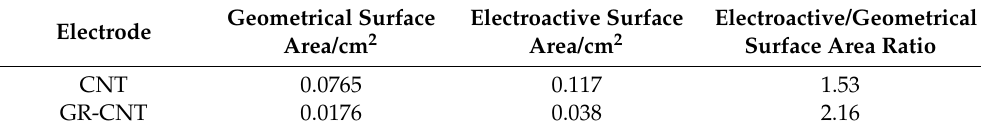
Table 2. Electroactive surface areas in comparison with geometrical ones. Geometrical Surface Electroactive Surface Electroactive/Geometrical Electrode Area/cm 2 Area/cm 2 Surface Area Ratio CNT 0.0765 0.117 1.53 GR-CNT 0.0176 0.038